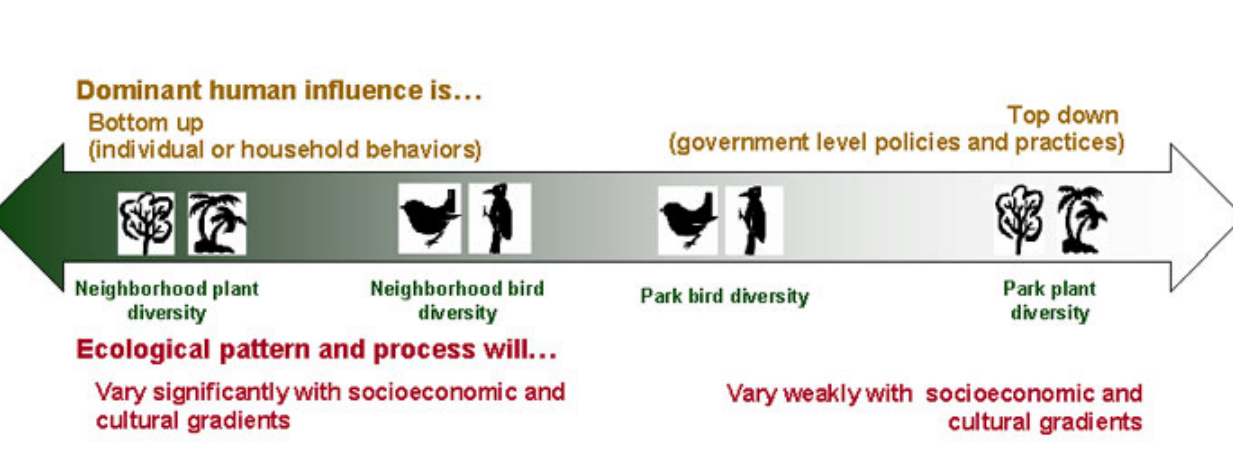
Fig. 1. Patterns of biodiversity considered in this paper, and predictions concerning how they will vary relative to socioeconomic and cultural